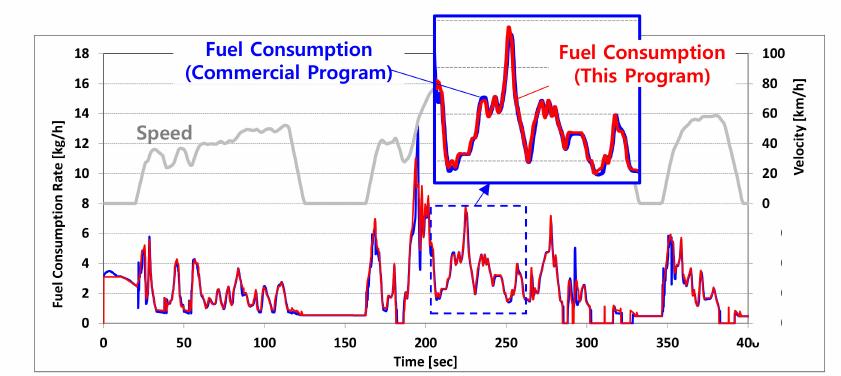
Figure 3. Comparison of the fuel consumption rate calculated by our program and another commercial